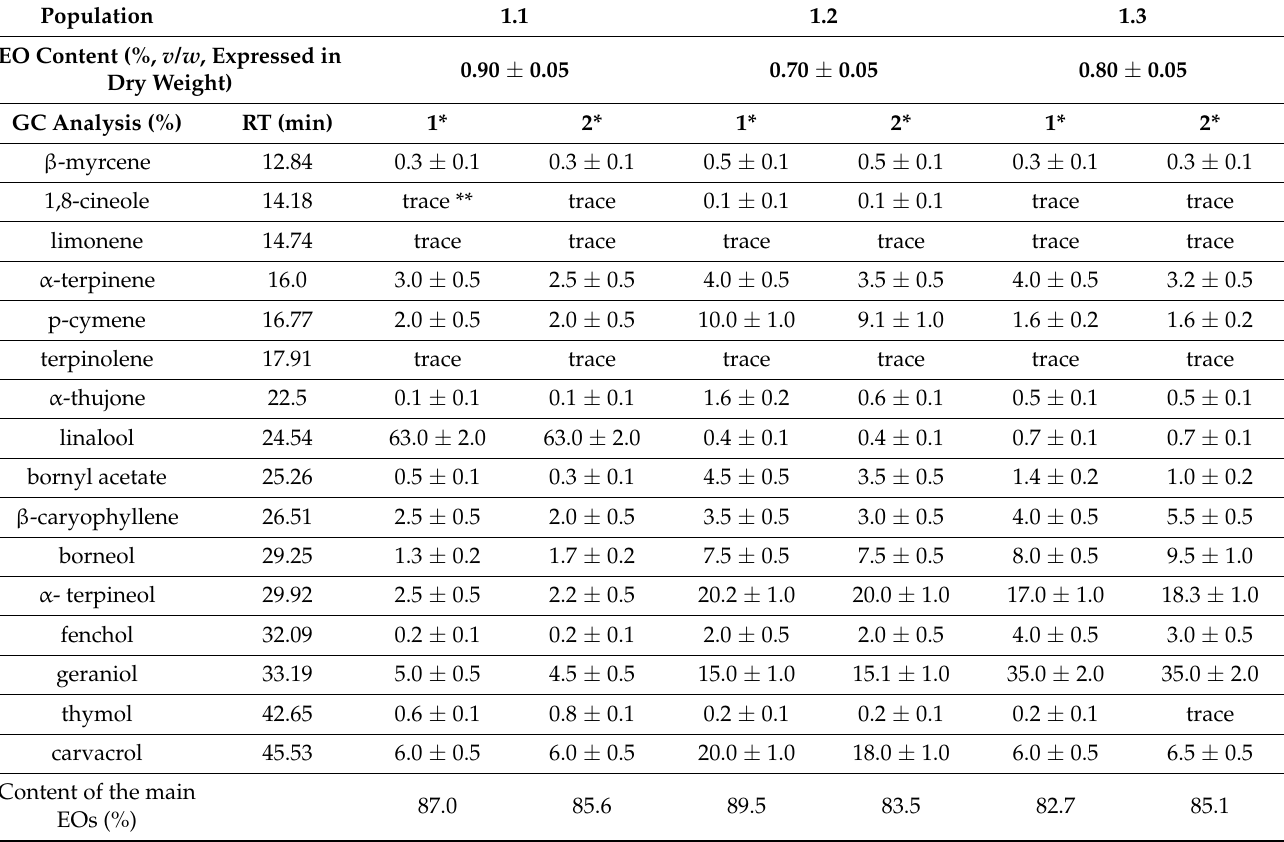
Table 1. The component composition of essential oils of Th. Serpyllum from different places of plant population growth (x ±